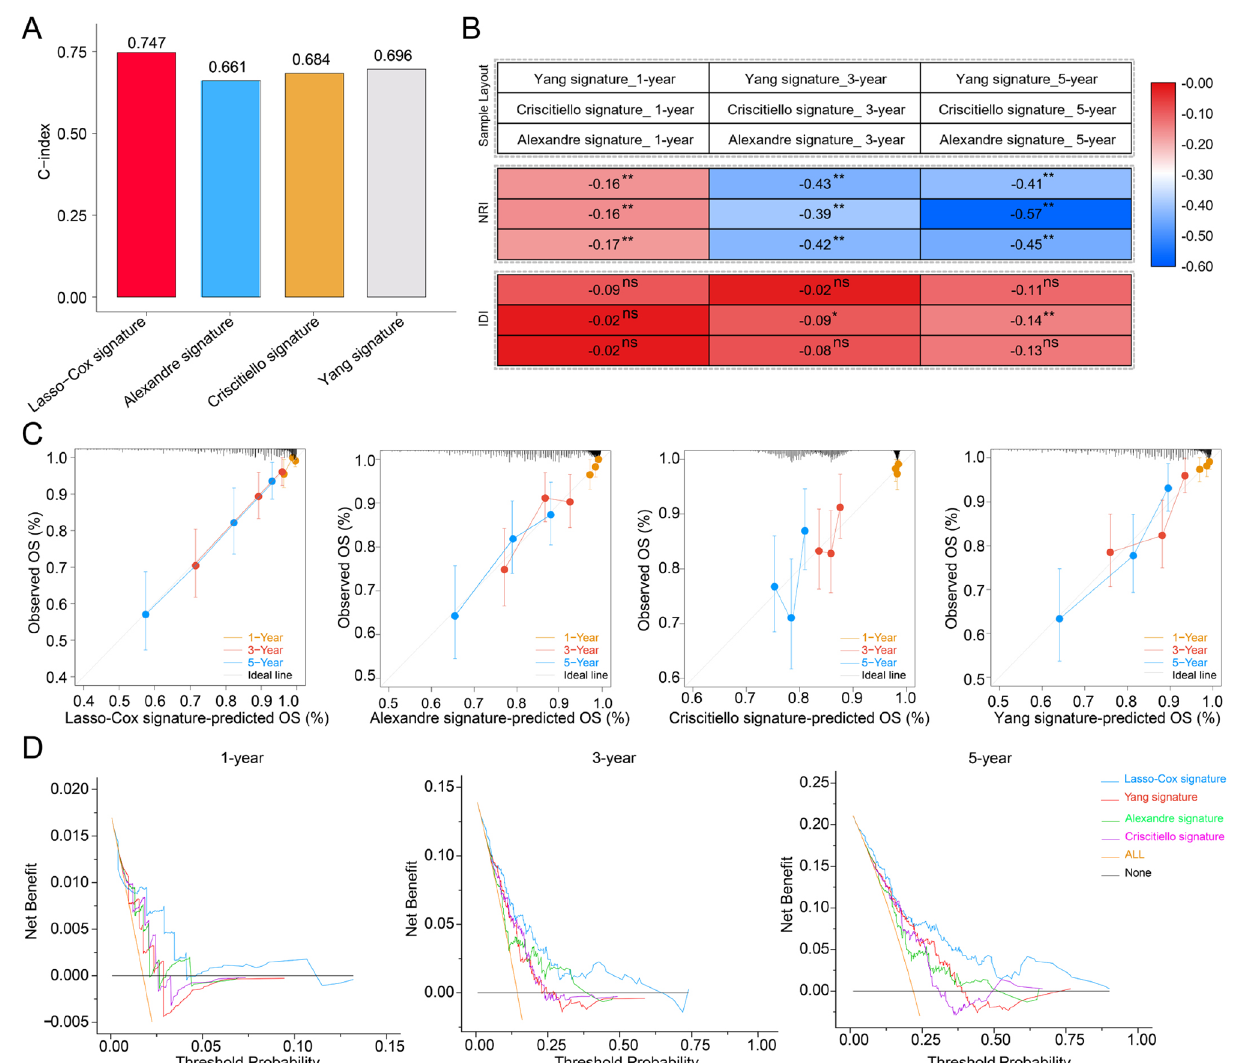
Figure 7. Evaluation of Lasso–Cox versus reported models in the integrated dataset (includig TCGA-TNBC, GSE58812 and GSE135561). ( A ) C-index analysis of the Lasso–Cox Signature, Criscitiello Signature, Alexandre Signature and Yang Signature. ( B ) INR and IDI analysis between reported models and Lasso–Cox model. ( C , D ) 1-year, 3-year and 5-year of calibration curve analysis and decision curve analysis (DCA) among Lasso– Cox Signature, Criscitiello Signature, Alexandre Signature and Yang Signature. *: P < 0.05; **: P < 0.01; ns: no significance.